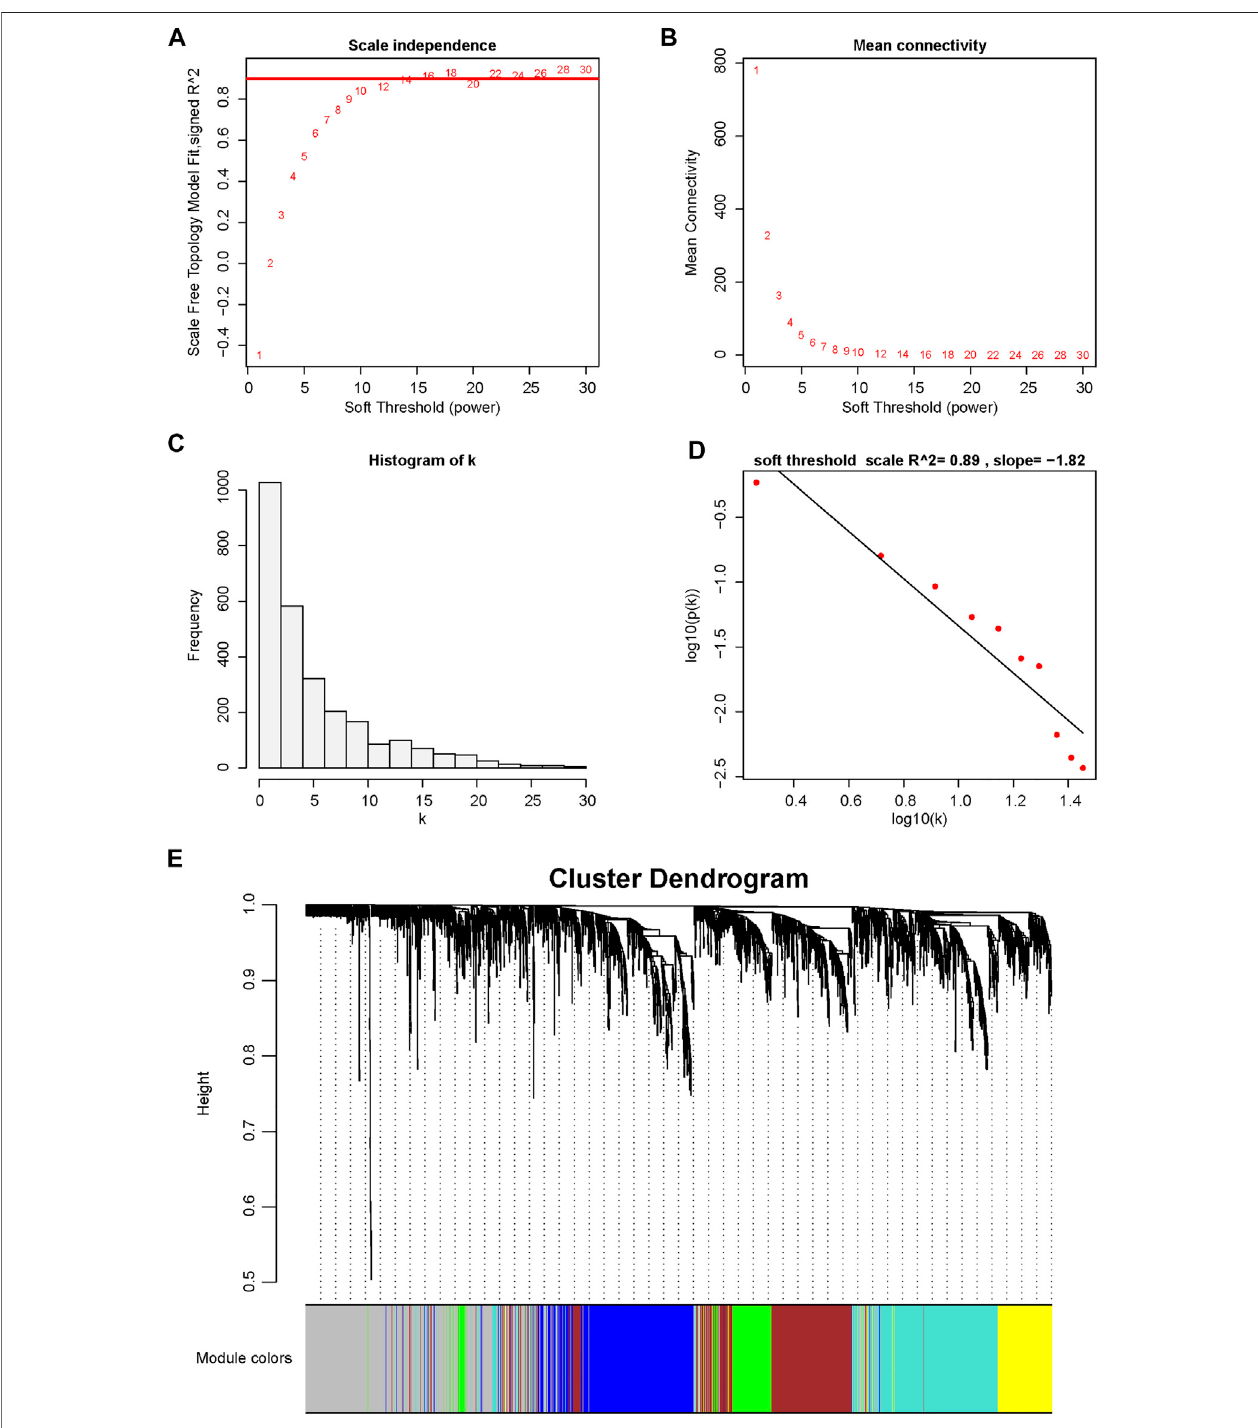
FIGURE 3 | Determination of soft-thresholding power in WGCNA. (A) Analysis of the scale-free fi tting indices for various soft-thresholding powers ( β ). (B) Mean connectivity analysis of various soft-thresholding powers. (C) Histogram of the connection distribution when β = 12. (D) Checking the scale-free topology when β = 12. (E) Cluster dendrogram of the coexpression network modules is ordered by hierarchical clustering of genes based on the 1-TOX matrix. Different colors represent different modules.